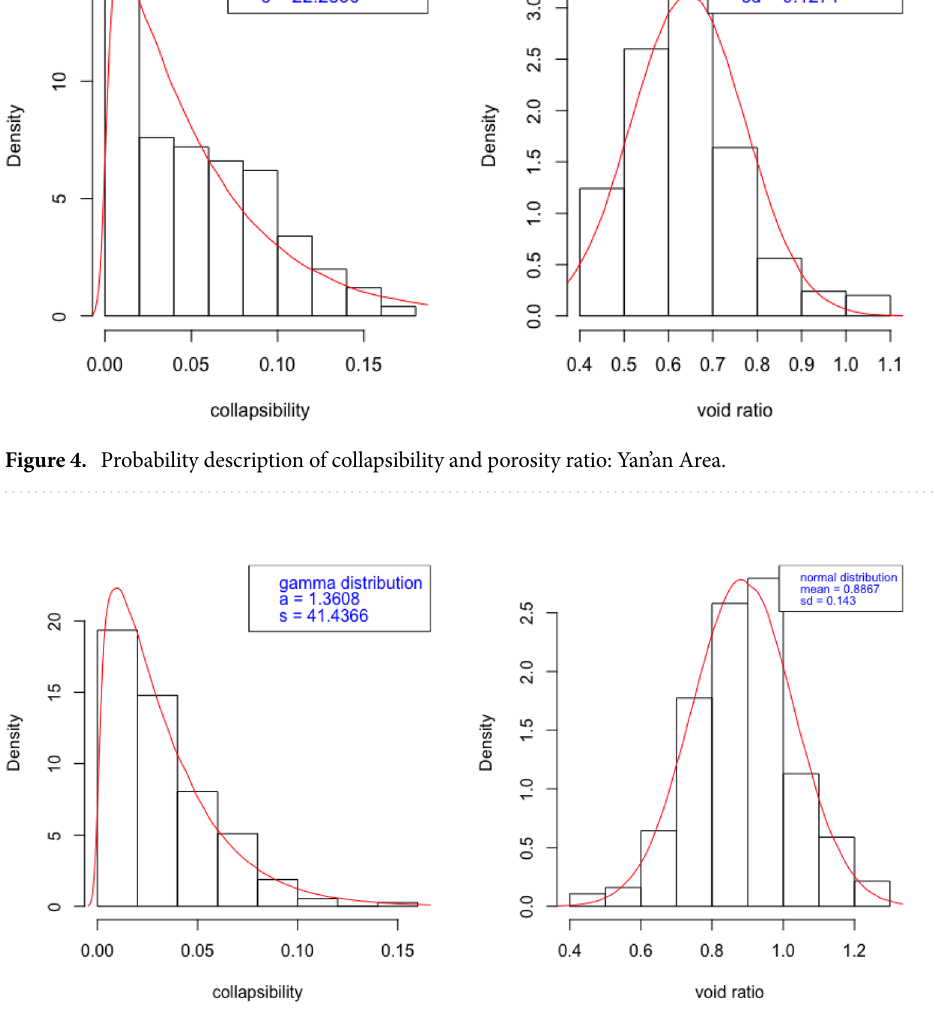
Figure 5. Probability description of collapsibility and porosity ratio: Lv Liang